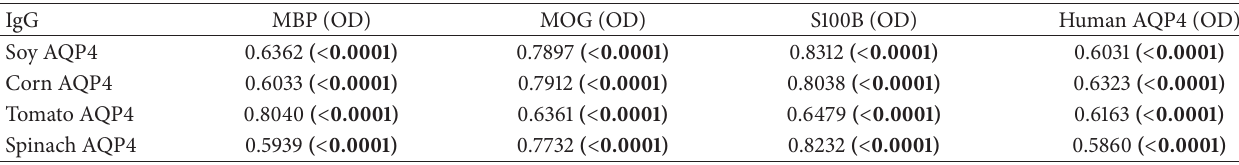
Table 2: Results of the simple linear regression between each pair of lgG isotypes of the food proteins and brain proteins in RRMS patients. The first number in each cell presents corresponding Pearson’s correlation coefficient and the second number in parentheses presents its 𝑝 value. Small 𝑝 values (less than 0.05) are marked in bold. Note that 𝑅 2 values of these regressions are the squares of Pearson’s correlation coefficients.